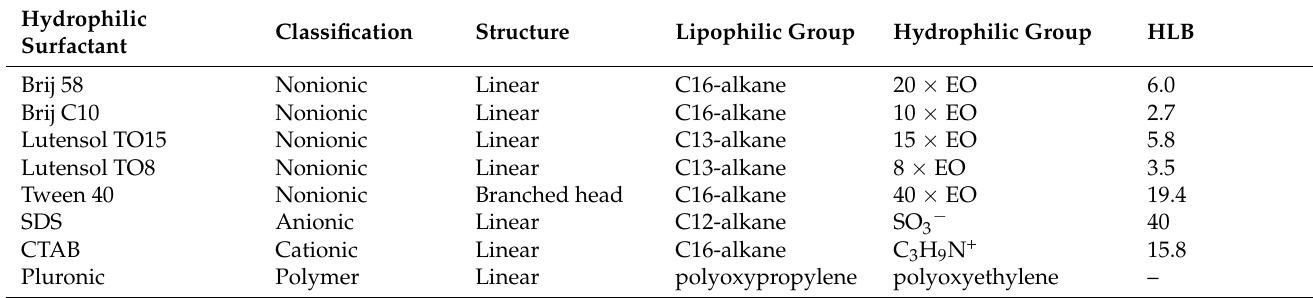
Table 1. List of the examined hydrophilic surfactants. They are ordered in different classification groups. Additionally, the chemistry of the lipophilic and the hydrophilic groups are given. The number of ethoxylate groups is abbreviated with